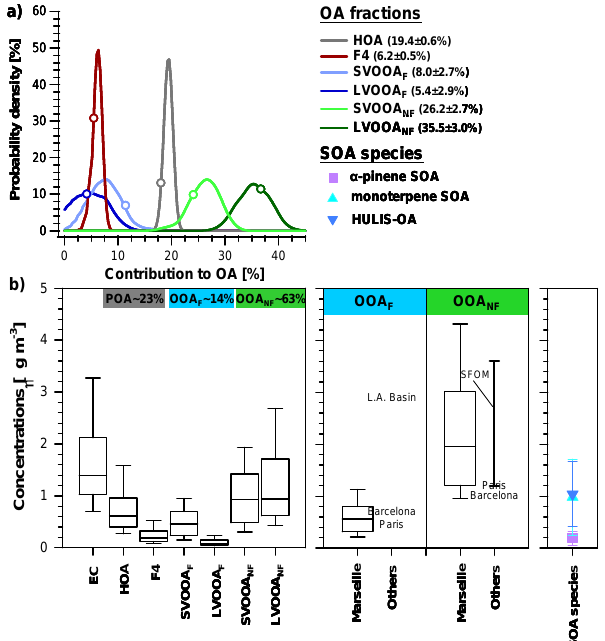
Fig.7: Fossil and non-fossil origins of POA (HOA and industrial OA, F4) and OOA (SV-OOA 1150 and LV-OOA). a) The open circles denote estimates determined using a multiple regression 1151 Fig. 7. Fossil and non-fossil origins of POA (HOA and industrial approach combining AMS/PMF2 results with 14 C measurements. The sensitivity of these 1152 OA, F4) and OOA (SVOOA and LVOOA). (a) The open circles estimates to different uncertainties and biases are presented by solid lines as frequency 1153 distributions of the contributions of the different fractions, calculated using a random sampling 1154 denote estimates determined using a multiple regression approach algorithm. From this, it is possible to determine the best estimates for the contributions of OA 1155 combining AMS/PMF2 results with 14 C measurements. The sensi- fractions and their associated uncertainties, presented in figure legend. Differences between the 1156 best estimates determined using the random sampling algorithm (Fig. legend) and those 1157 tivity of these estimates to different uncertainties and biases are pre- determined using the multiple regression approach (open circles) provide an estimation of the 1158 sented by solid lines as frequency distributions of the contributions potential biases: It shows that we might underestimate the contributions of F4, HOA, SVOOA nf 1159 and LVOOA f by 9%, 6%, 5% and 23%, respectively and overestimate the SVOOA f and 1160 of the different fractions, calculated using a random sampling algo- LVOOA nf by 34% and 5%, respectively. b) Contributions, in μg m -3 , of OA fractions during the 1161 rithm. From this, it is possible to determine the best estimates for campaign obtained using the multiple regression estimations in Fig.7a (open circles). Fossil and 1162 non-fossil OA fractions estimated here are compared with results reported for summertime in 1163 the contributions of OA fractions and their associated uncertainties (see figure legend). Differences between the best estimates deter- mined using the random sampling algorithm (fig. legend) and those determined using the multiple regression approach (open